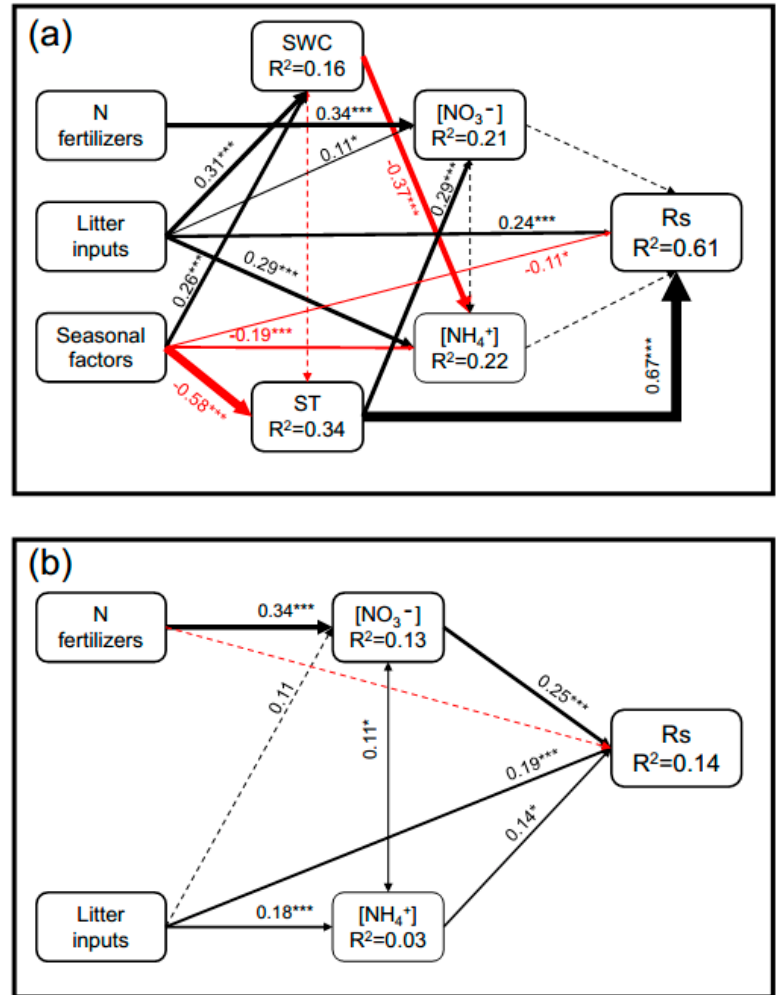
Figure 6. Structural equation models (SEM) depicting the influence of N fertilizers, litter management, and inorganic nitrogen with ( a ) or without hydrothermal factors ( b ) on soil respiration (Rs) rates. The solid lines refer to significant relationships, whereas the dashed lines refer to nonsignificant relationships ( p < 0.05). The arrows represent the directional influence of one variable upon another, whereas the double-headed arrow lines exhibited the relationship between two variables, which is not presumed to be causal and unidirectional. The black arrows show positive effects and red represent the negatives. Numbers beside the line are standardized coefficients. R 2 values associated with response variables indicate the proportion of variation explained by the relationships with other variables.